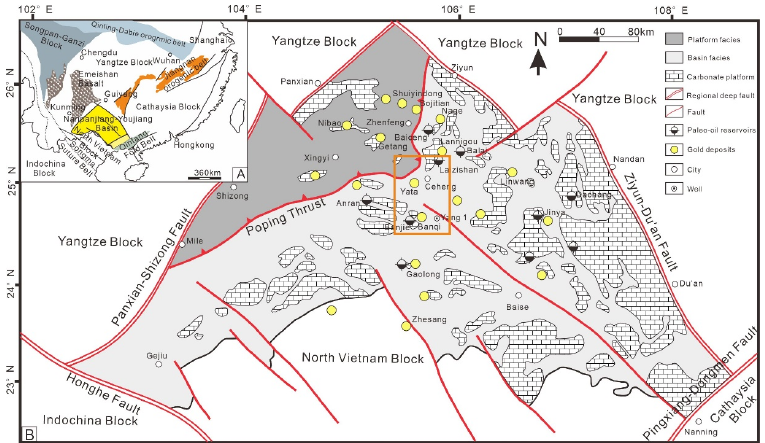
Figure 1. ( A ) Tectonic location map of the Nanpanjiang-Youjiang Basin [18]). ( B ) Simplified geological and structural map of the Nanpanjiang Basin, showing locations of both hydrocarbon reservoir and gold deposits[17].